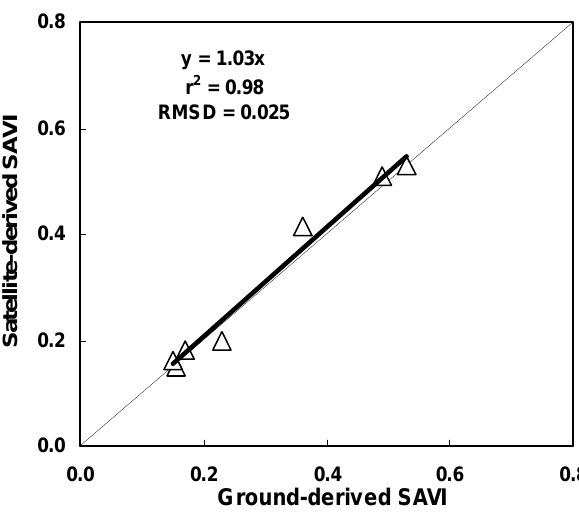
Fig. 2. Satellite-derived soil adjusted vegetation index (SAVI) vs. Fig.2 Satellite-derived soil adjusted vegetation index (SAVI) vs. 17 ground-derived SAVI at the wheat experiment. The thin solid diag- onal line represents the 1:1 line, while the dark line segment repre- ground-derived SAVI at the wheat experiment. The thin solid diagonal 18 sents the linear regression through the points. line represents the 1:1 line, while the dark line segment represents the 19 linear regression through the points. 20